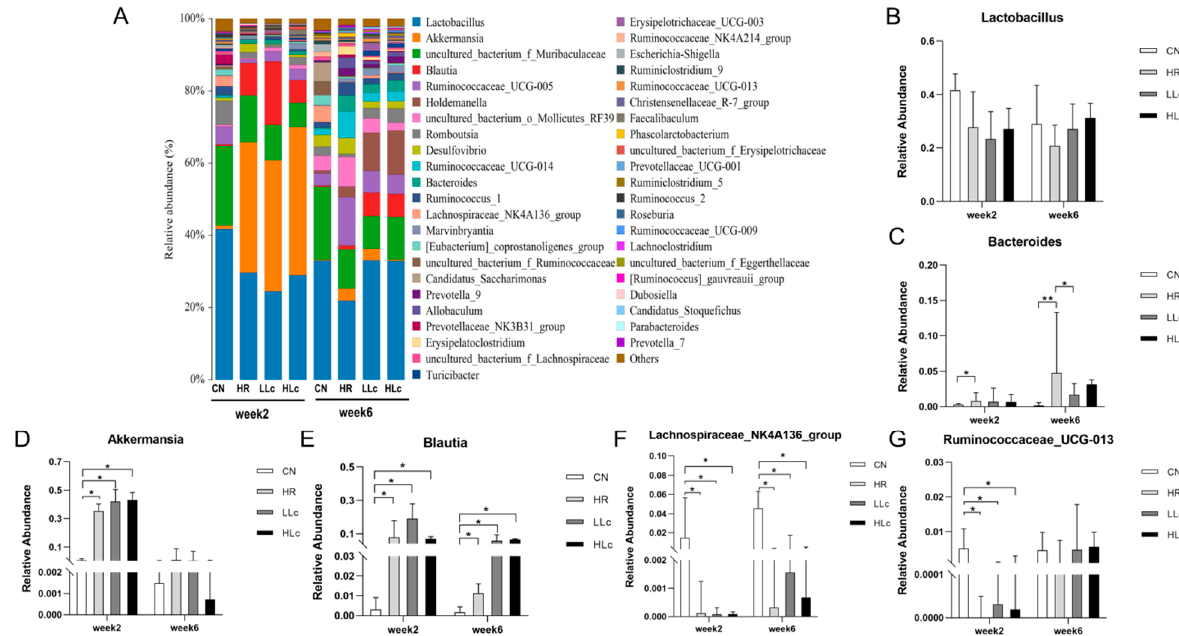
Figure 4. Lactobacillus casei and anti-TB drugs change the community structure of gut microbes. ( A ) Relative abundance of microbial taxa determined by 16S rRNA analysis of fecal bacteria at genus level, week 2 and week 6. Percentages of bacteria with greater abundance in the gut microbial communities at the genus level: ( B ) Lactobacillus ; ( C ) Bacteroides ; ( D ) Akkermansia ; ( E ) Blautia ; ( F ) Lachnospiraceae_NK4A136_group ; ( G ) Ruminococcaceae_UCG-013 . N = 5 in each group, values are presented as mean ± SD, * indicates p < 0.05, ** indicates p < 0.01. CN: control group, HR: isoniazid + rifampicin model group, LLc: HR + low dose L. casei ATCC334 group, HLc: HR + high dose L. casei ATCC334 group.